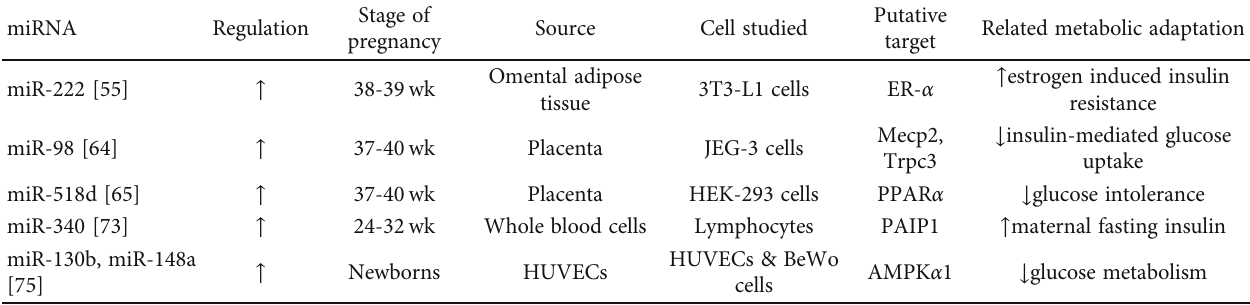
Table 1: Studies investigating the regulation of miRNA and related maternal metabolic adaptation in GDM.